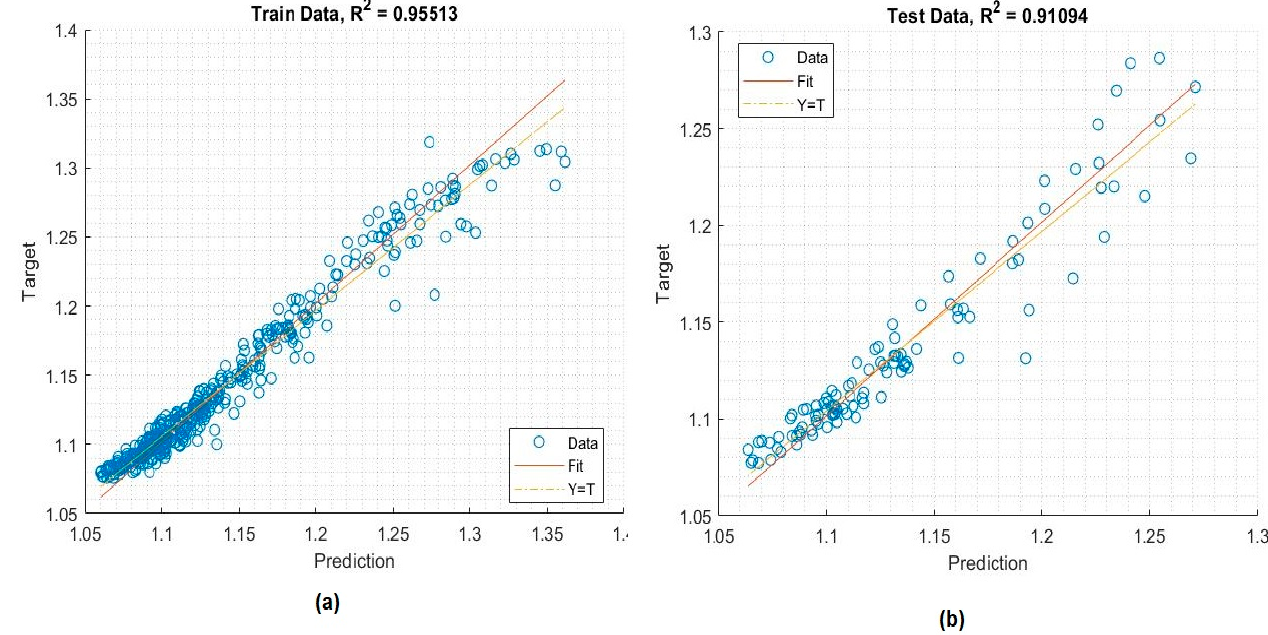
Figure 9. Performance of the GRU model for predicting bitcoin price: ( a ) training phase and ( b ) testing phase.